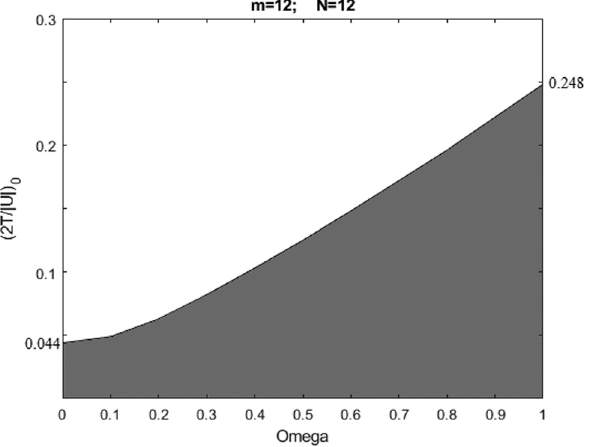
Figure 3: Critical dependence of the virial ratio on the rotation parameter for m 12 = ; N 12 = .